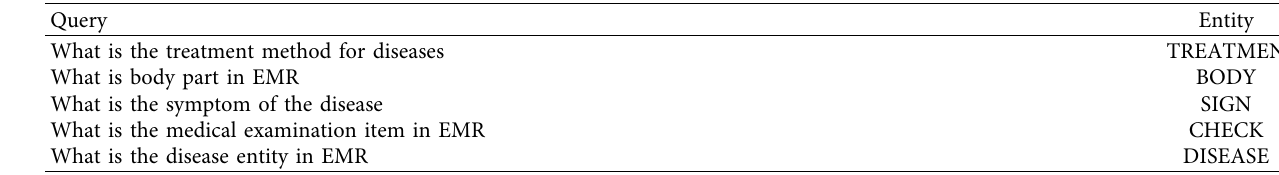
Table 3: Set of queries about different